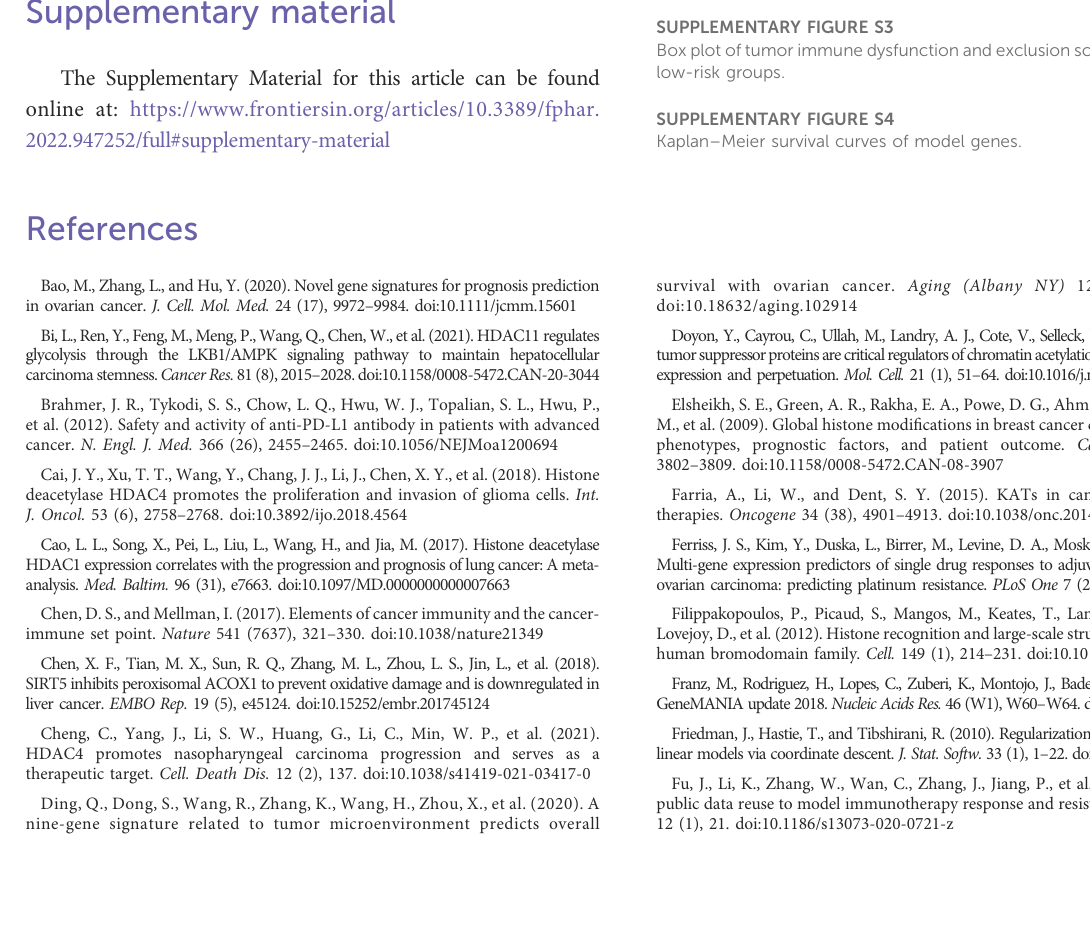
SUPPLEMENTARY FIGURE S2 Immune cell in fi ltration and clinical grading.